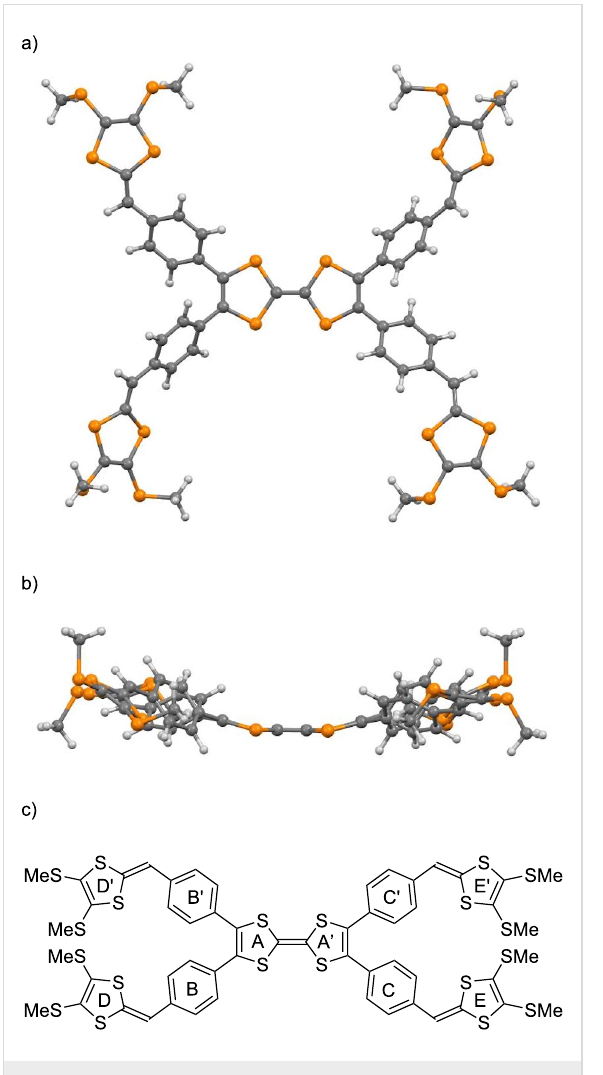
Figure 2: An optimized structure of 1a . a) Top view, b) side view, and c) labeling of the 1,3-dithiole rings.